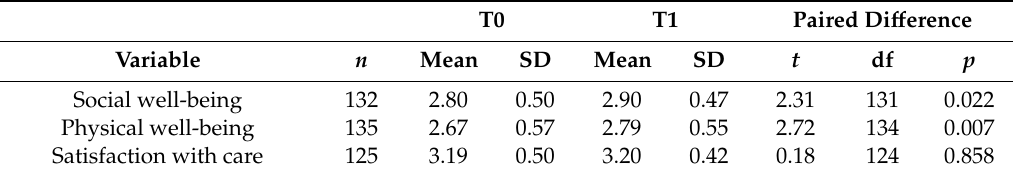
Table 3. Paired sample t tests social well-being, physical well-being and satisfaction with care. T0 T1 Paired Di ff erence Variable n Mean SD Mean SD t df p Social well-being 132 Physical well-being Satisfaction with care